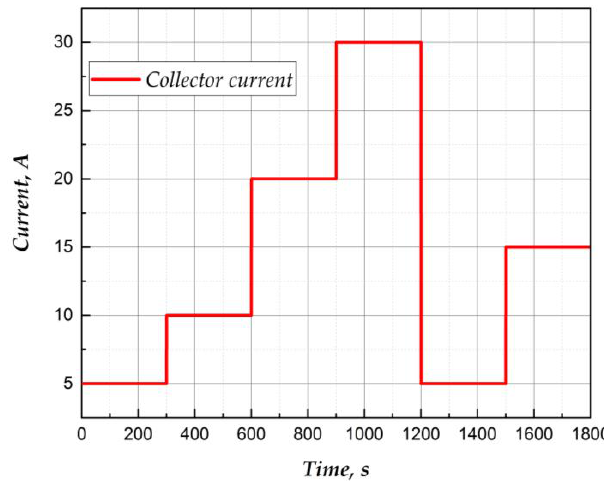
Figure 14. The input of the collector current.